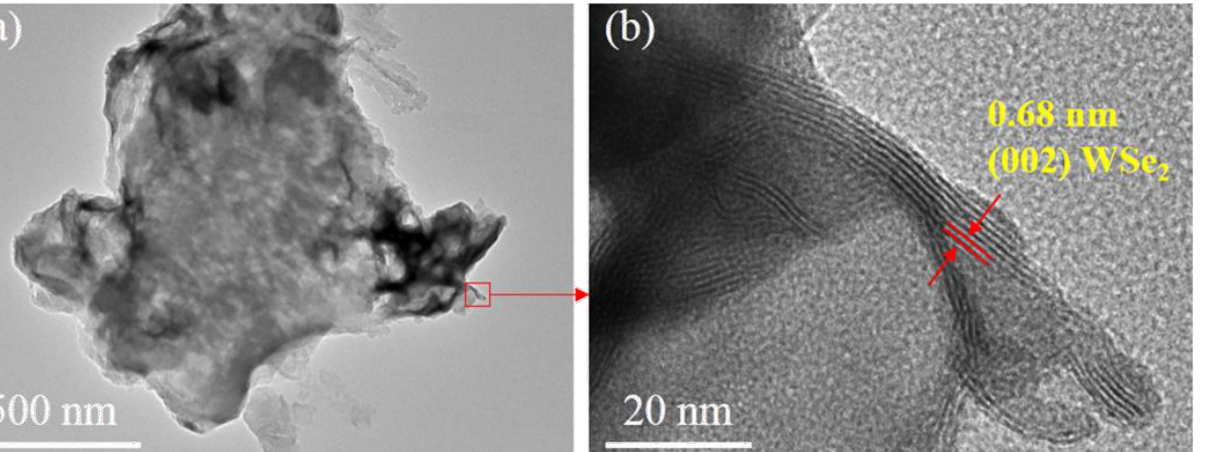
Figure 2. SEM images of ( a ) PCN, ( b ) WSe 2 , and ( c , d ) CNW2; ( e ) HAADF-SEM image and ( f ) corresponding EDX elemental mapping images of CNW2. The micromorphology of PCN and CNW composite materials were further analyzed by TEM and HRTEM (Figure 3 and Figure S4). As shown in Figure S4a,b, there are no lattice fringes locally due to the low crystallinity of PCN. As shown in Figure 3a, WSe 2 nanosheets are mainly loaded on the edge of g-C 3 N 4 . WSe 2 exhibits distinct lattice fringes with a fringe spacing of about 0.68 nm, corresponding to the (002) crystal plane of WSe 2 [40,41]. Moreover, the size of WSe 2 nanosheets is approximately 30 nm, much smaller than the size of PCN nanosheets. These results reveal that the WSe 2 nanosheets were successfully loaded onto the PCN, which is consistent with the SEM observations.